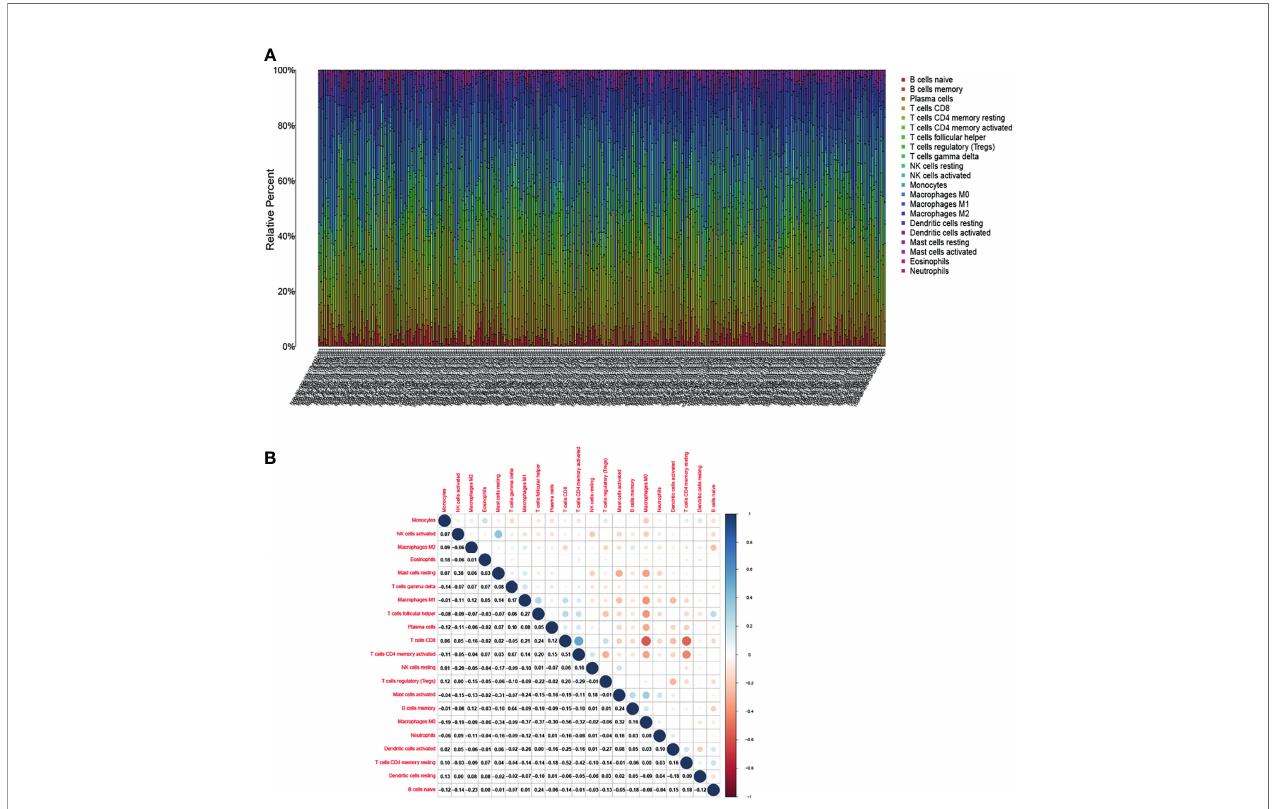
FIGURE 6 | Tumor-in fi ltrating immune cell (TIC) pro fi le in tumor samples and correlation analysis. (A) Proportion of 21 kinds of TICs in UCEC tumor samples is displayed by a ballot plot. Column names of the plot correspond to sample ID. (B) Heatmap presenting the relationship between 21 kinds of TICs and numeric in each tiny box representing the association P -value between two kinds of cells. The shade of each tiny color box indicates the corresponding association value between two cells. The signi fi cance test was displayed using Pearson correlation coef fi